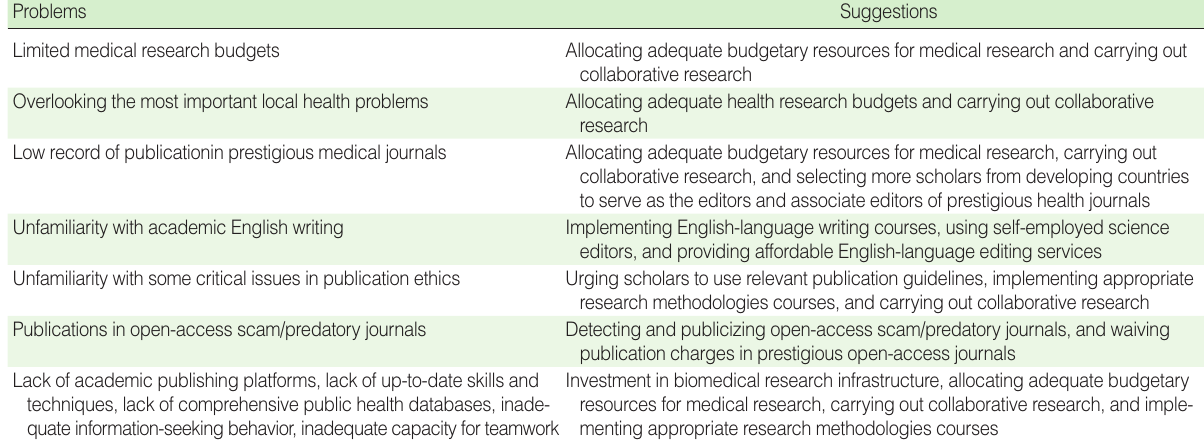
Table 1. Summary table of problems and suggestions associated with the current system of English-language academic publication